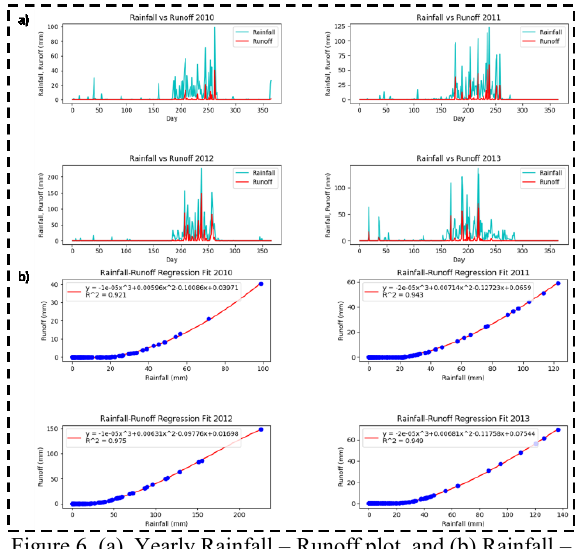
Figure 6. (a) Yearly Rainfall – Runoff plot, and (b) Rainfall – Runoff relationship for Consecutive Variations.